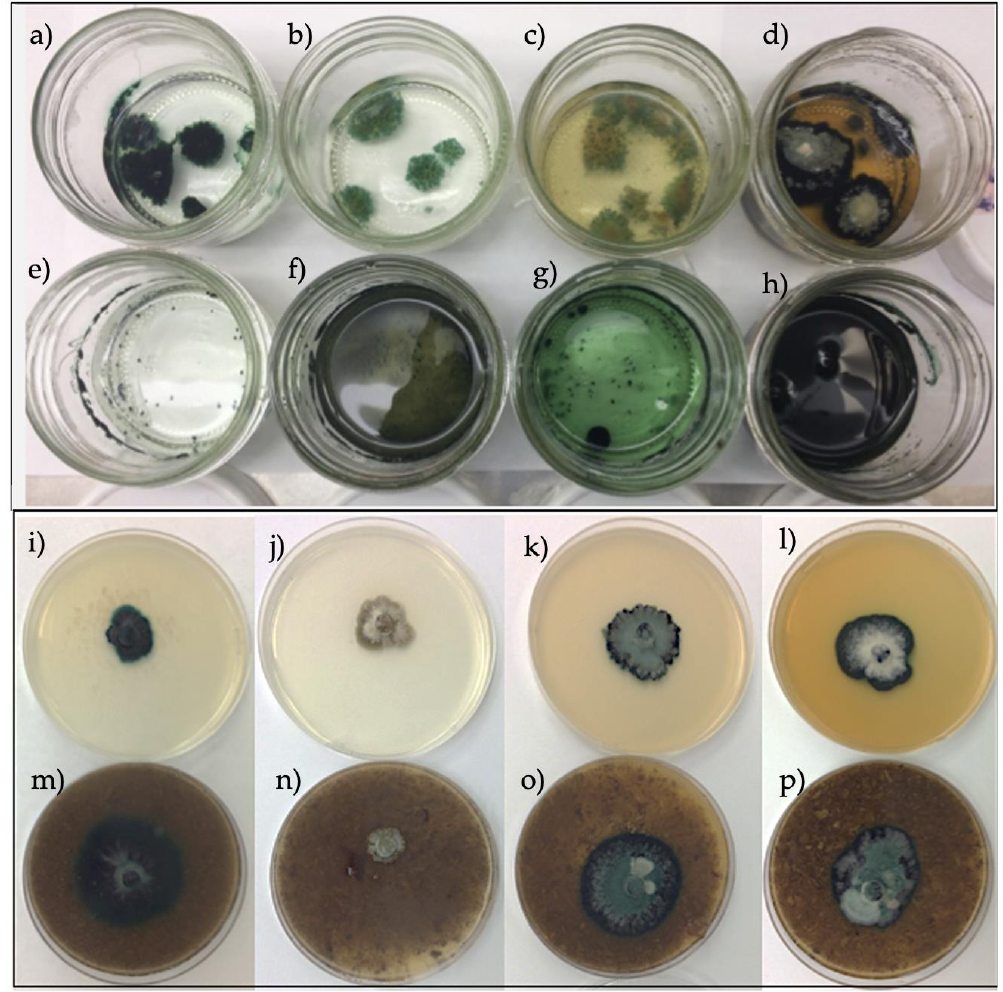
Figure 1. Cultures of Chlorociboria aeruginosa in all tested media at 9 weeks. All liquid cultures were shaken at 99 rpm. ( a ) Static honey liquid culture; ( b ) static potato dextrose broth (PDB) liquid culture; ( c ) static brewer’s malt liquid culture; ( d ) static lab-grade malt liquid culture; ( e ) shaking honey liquid culture; ( f ) shaking PDB liquid culture; ( g ) shaking brewer’s malt liquid culture; ( h ) shaking lab-grade malt liquid culture; ( i ) honey agar culture; ( j ) PDB agar culture; ( k ) brewer’s malt agar